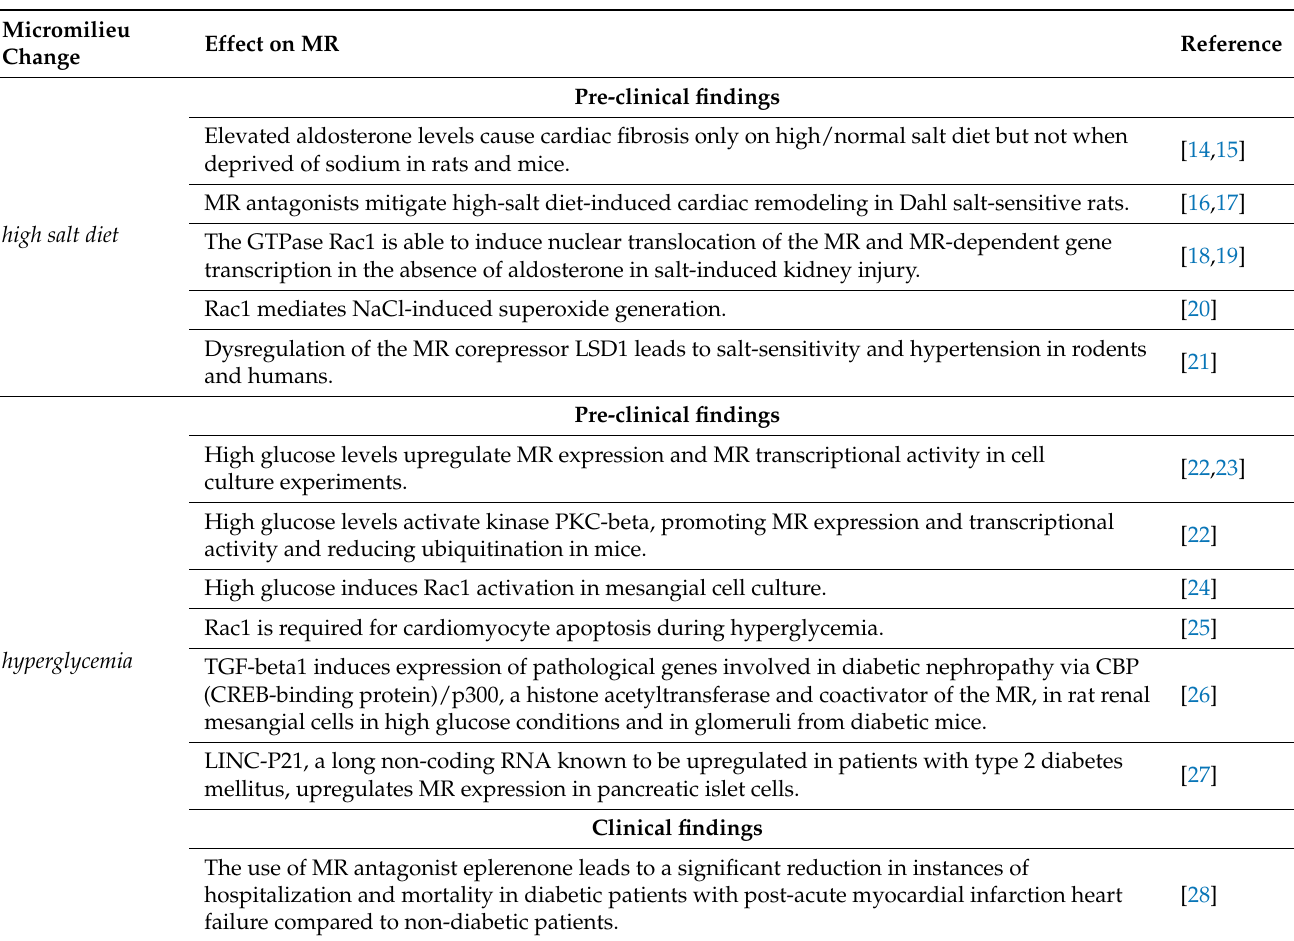
Table 1. Preclinical and clinical studies evaluating the role of micromilieu changes for the develop- ment of MR-related